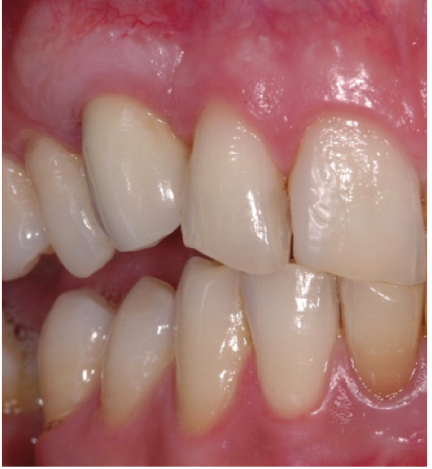
Figure 20: Final gold ceramic crown placed after 6 months of